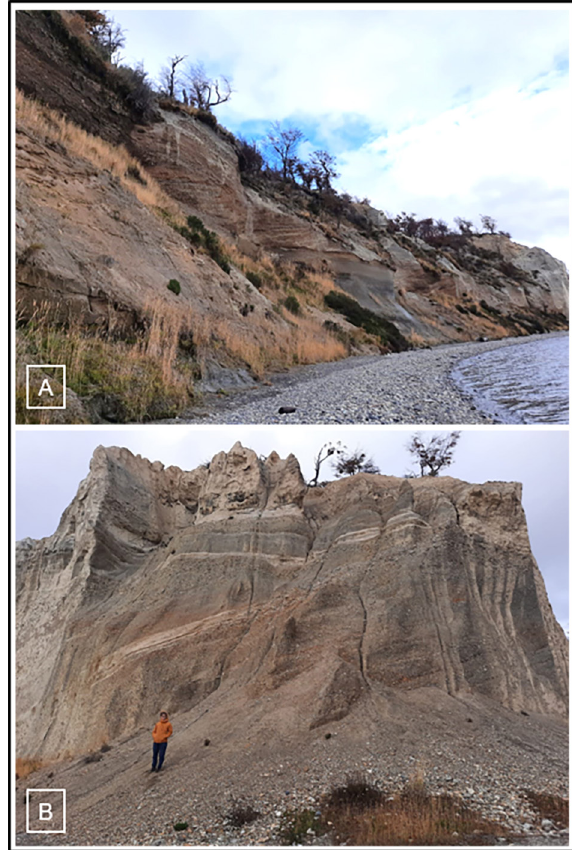
Fig. 6. Paleo-delta kame and basal moraine on Fagnano lake shore. A – general view of the paleo- delta kame deposits (to the west); the basal grey lacustrine sediments of the bottom set, the foreset gravel strata and the top set sandy-gravelly strata can be distinguished along with the exposure; B – section showing the three components of the paleo-delta kame sedimentary sequence and columnar basal till on the top. While the delta deposits belong to the last middle Pleistocene glaciations, the basal till is from the